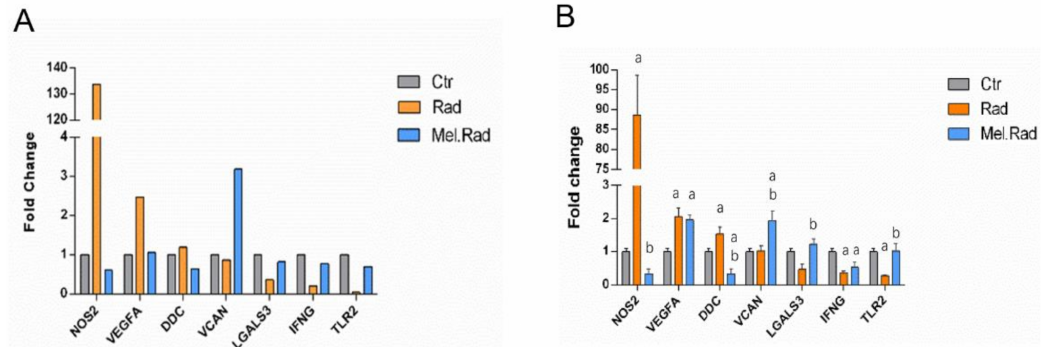
Figure 6. qRT-PCR validation of seven candidate DEGs. ( A ) The expression levels of the target genes of TRIM24 and S100A9 in the microarray data. ( B ) The expression levels of the target genes of TRIM24 and S100A9 validated in the qRT-PCR. Data are represented as mean ± SD, n = 3 mice/group. a p < 0.05 vs. Ctr; b p < 0.05 vs. Rad. NOS2, nitric oxide synthase 2, inducible; VEGFA, vascular endothelial growth factor A; DDC, dopa decarboxylase; VCAN, versican; LGALS3, lectin, galactose binding, soluble 3; IFNG, interferon gamma; TLR2, toll-like receptor